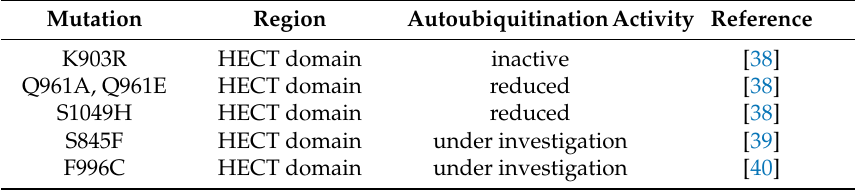
Table 1. Amino acid residues necessary for UBE3C enzymatic